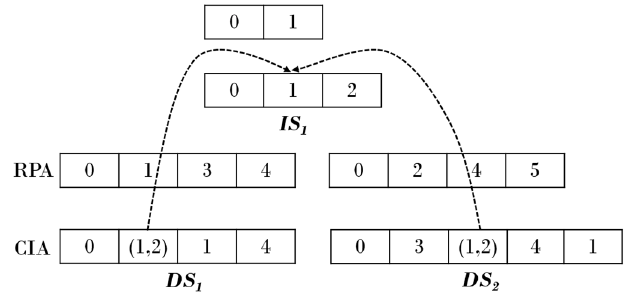
Figure 6. Modified compressed sparse row.